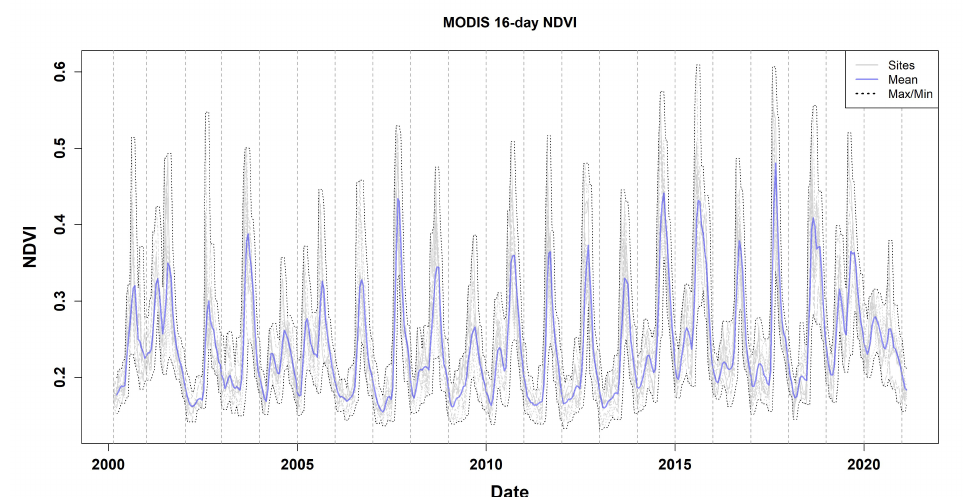
Figure A2. Seasonal and annual normalized difference vegetation index (NDVI) patterns from the Moderate Resolution Imaging Spectroradiometer (MODIS) satellite sensor, showing the timing of peak vegetation greenness typically occurring in August (Julian date = 220) and post growing season dormant period beginning in November at